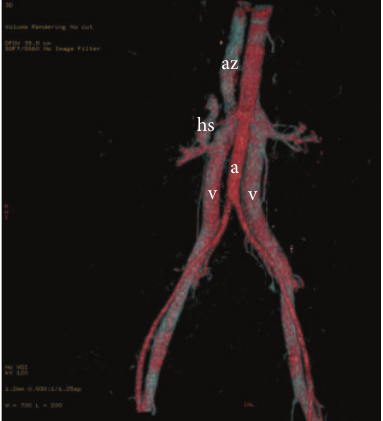
Figure 2: VR image coronal reconstruction shows double IVC (v), azygos continuation of the right IVC (az), and the hypoplastic hepatic segment (hs) of the IVC draining into the right IVC and the aorta (a).